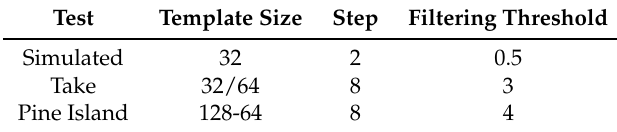
Table 2. Template size, grid step, and filtering threshold in different test cases (unit: pixels).